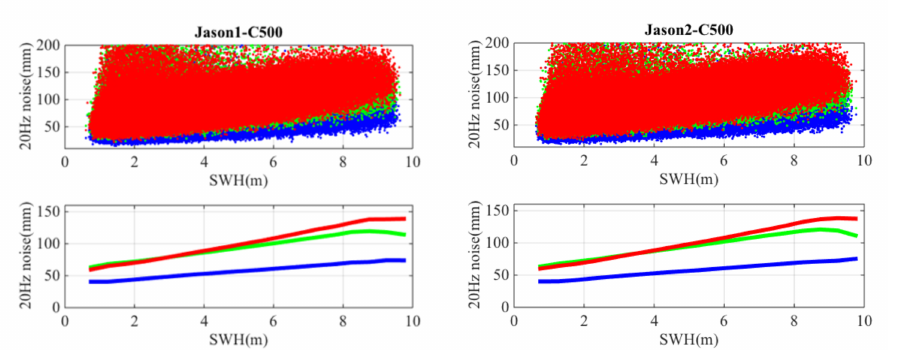
Figure A1. Standard deviation of retracked height with respect to EGM2008 for Jason-1 and Jason-2 sample cycle. Upper figures statistics for individual points. Lower figures: medians over 0.5 m SWH intervals. (Red: height from sensor geophysical data record. Green: height from first step of two-pass retracking. Blue: height from second step of two-pass